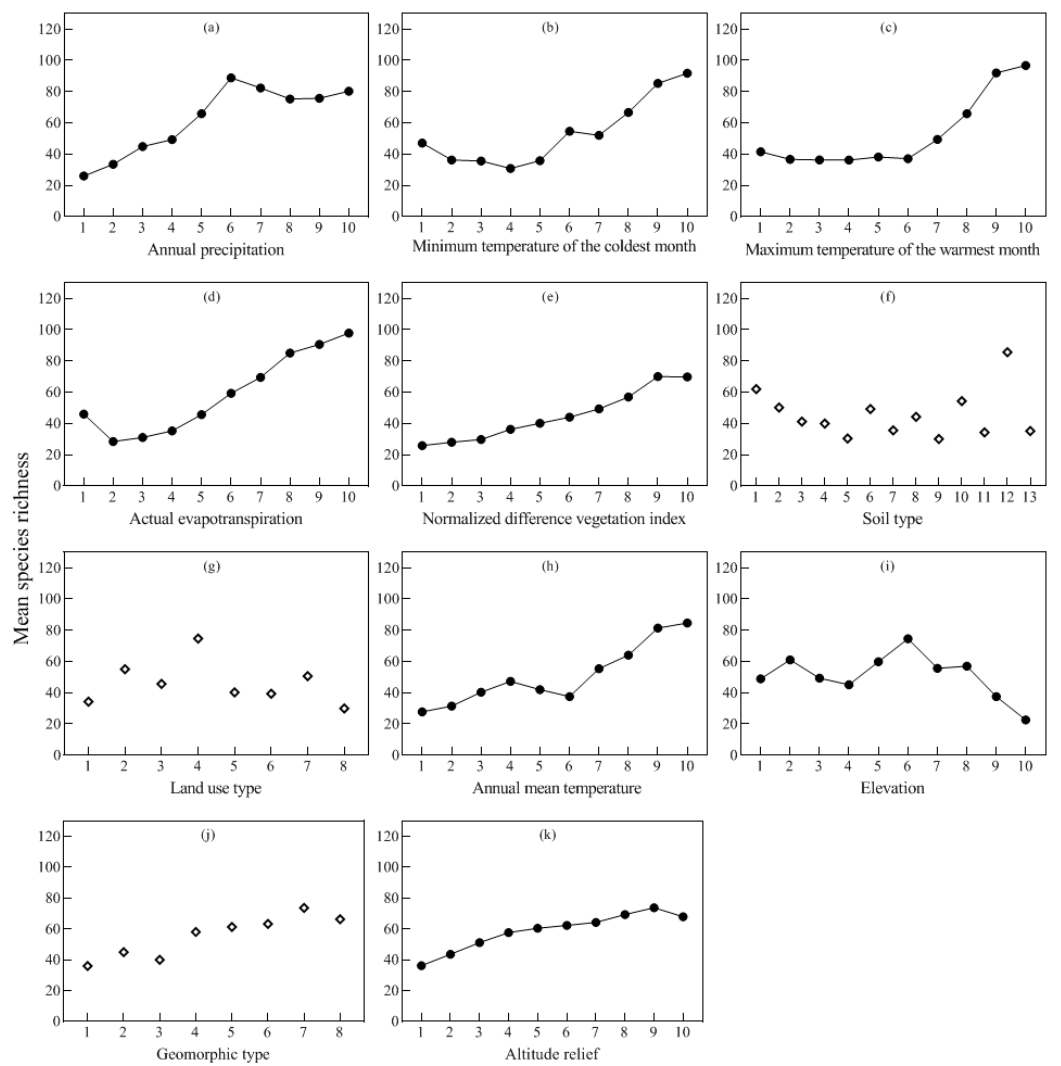
Figure 6. The appropriate range of environmental factors for the richness distribution of terrestrial mammals.